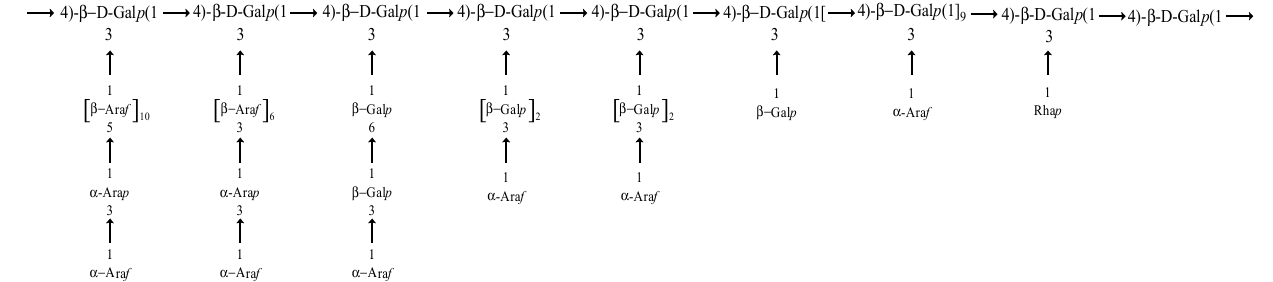
Figure 10. Putative structure of LRP3-S1.